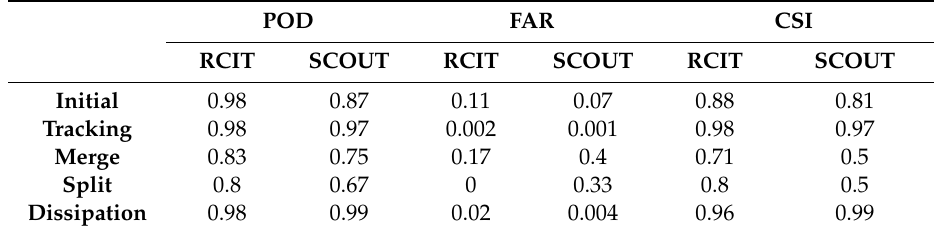
Table 6. POD, FAR, and CSI scores for rain cell assignments from RCIT and SCOUT tracking approaches, respectively.